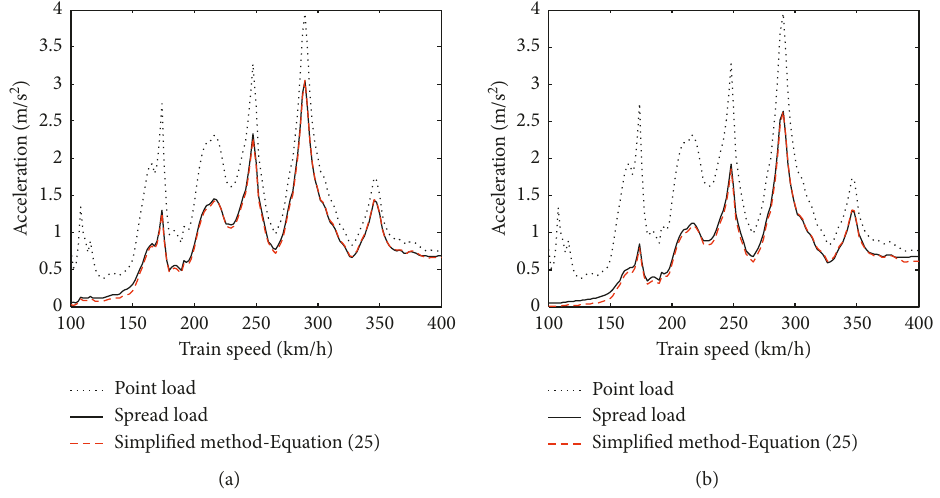
Figure 10: Maximum bridge acceleration (ML model). (a) EC block load. (b) Triangular load.